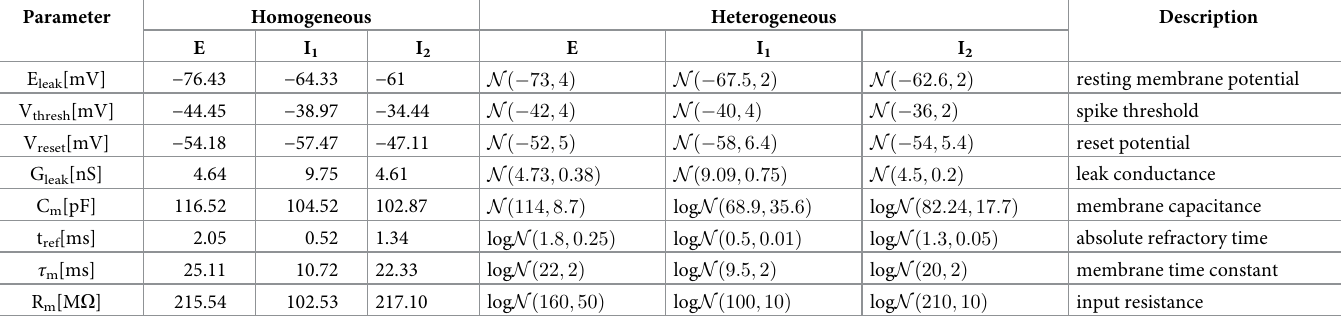
Table 1. Single neuron parameter sets. In the heterogeneous condition, three neuronal types have the values of the described parameters randomly drawn from a normal ( N ) or lognormal ( log N ) distribution. The parameter values for these distributions were determined taking into account multiple sources of experimental data (see S1 Appendix). Note that, to make comparisons simpler, the values displayed for the lognormal distributions correspond to the mean and standard deviation of the distribu- tion, not the actual μ and σ parameters (see Materials and methods).